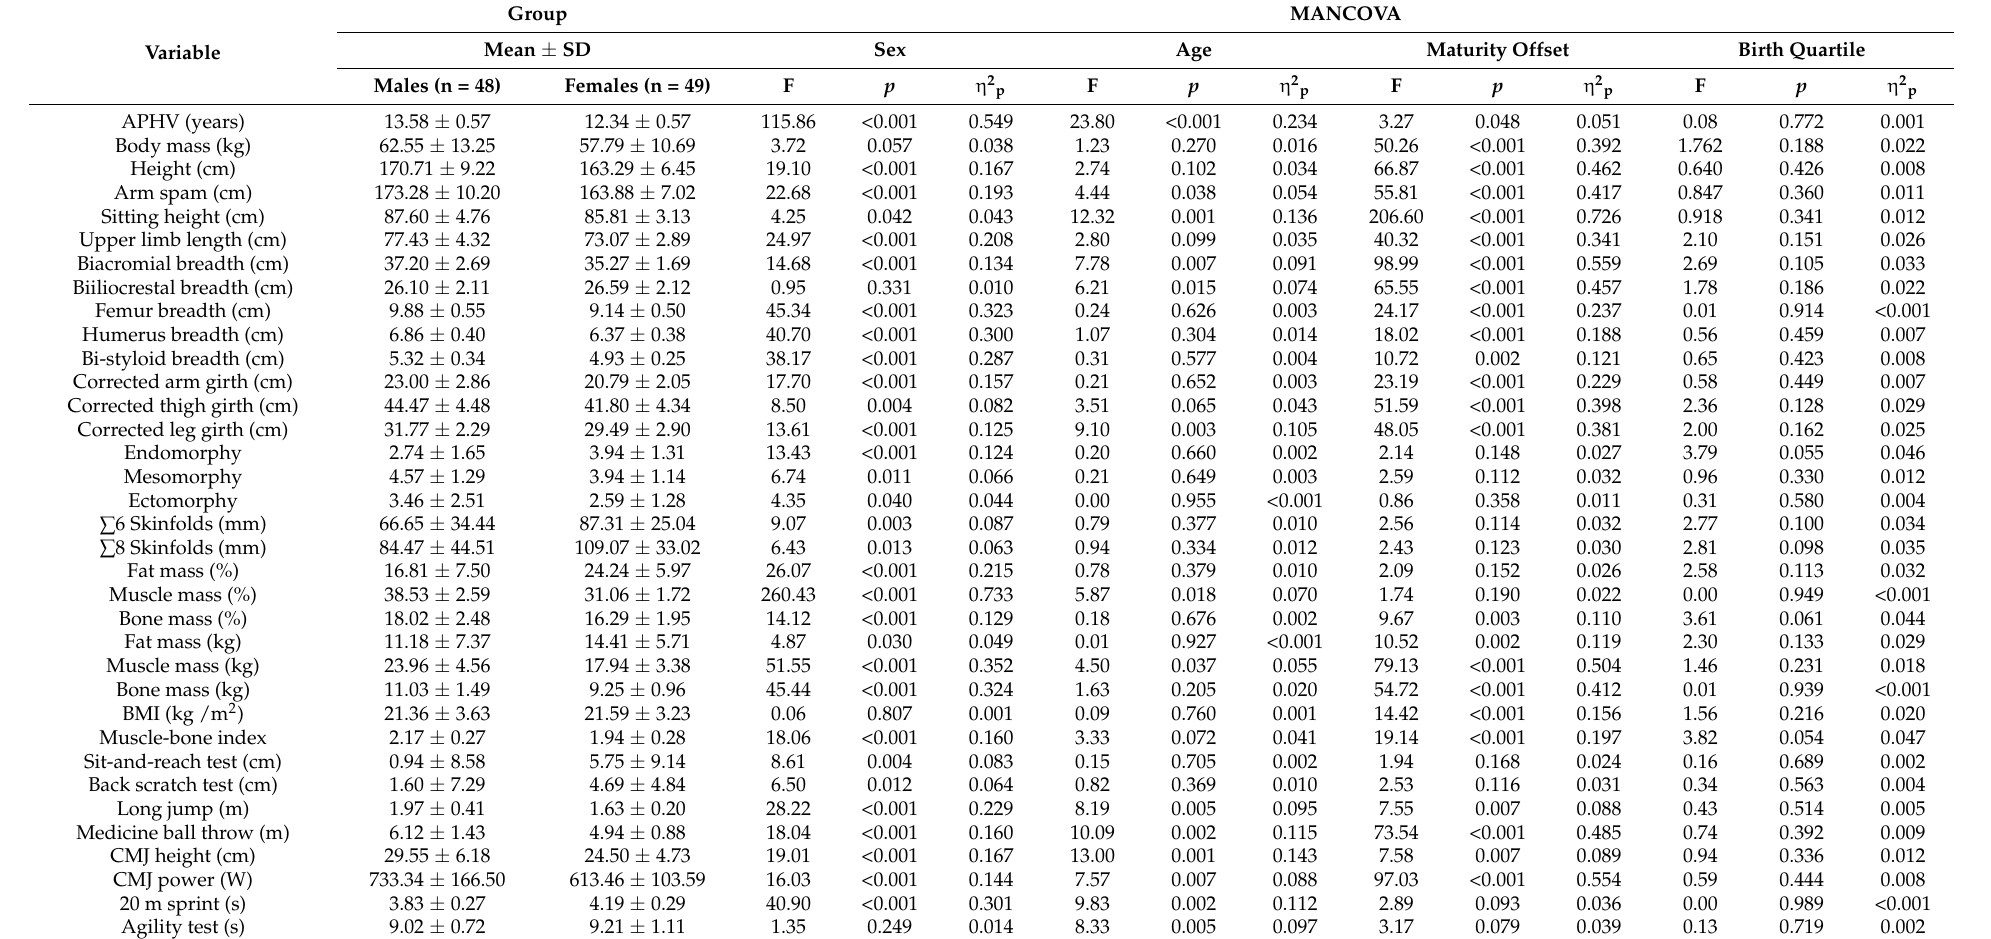
Table 1. Differences between groups in maturation, kinanthropometric and physical fitness variables and covariables main